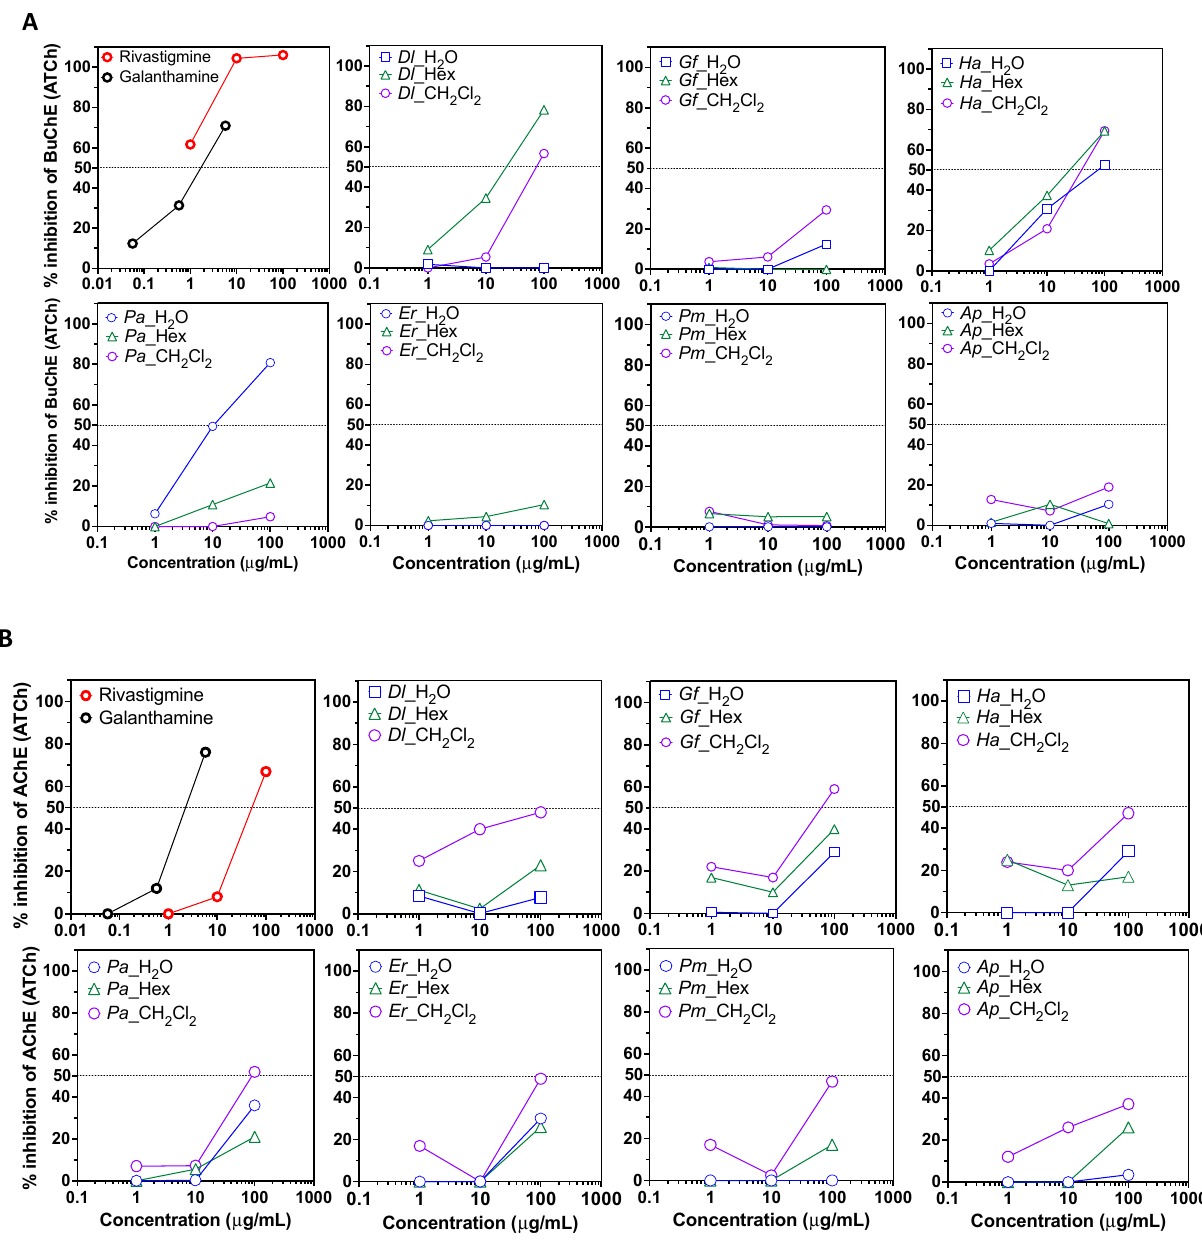
Figure 2. Anti-cholinesterase potential of plant extract fractions. ( A ) Butyrylcholinesterase (BuChE) inhibition assay using acetylthiocholine (ATCh) as a substrate. ( B ) Acetylcholinesterase inhibition assay. Data are presented as a ratio of absorbance over the corresponding negative control (DMSO or H 2 O solvants) at each concentration. Shown are representative results of at least two independent experiments. Dl: Daucus lopadusanus ; Gf: Glaucium flavum ; Ha: Hypericum aegyptum ; Pa: Periploca angustifolia ; Es: Echinops spinosus ; Pm: Prasium majus ; Ap: Atriplex halimus ; H 2 O: H 2 O phase; HE: n -hexane extract; MC: CH 2 Cl 2